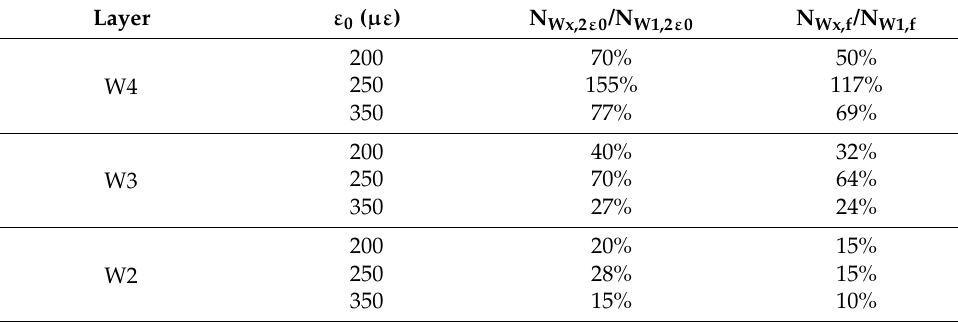
Table 9. Percentage increase of load repetitions compared to W1.